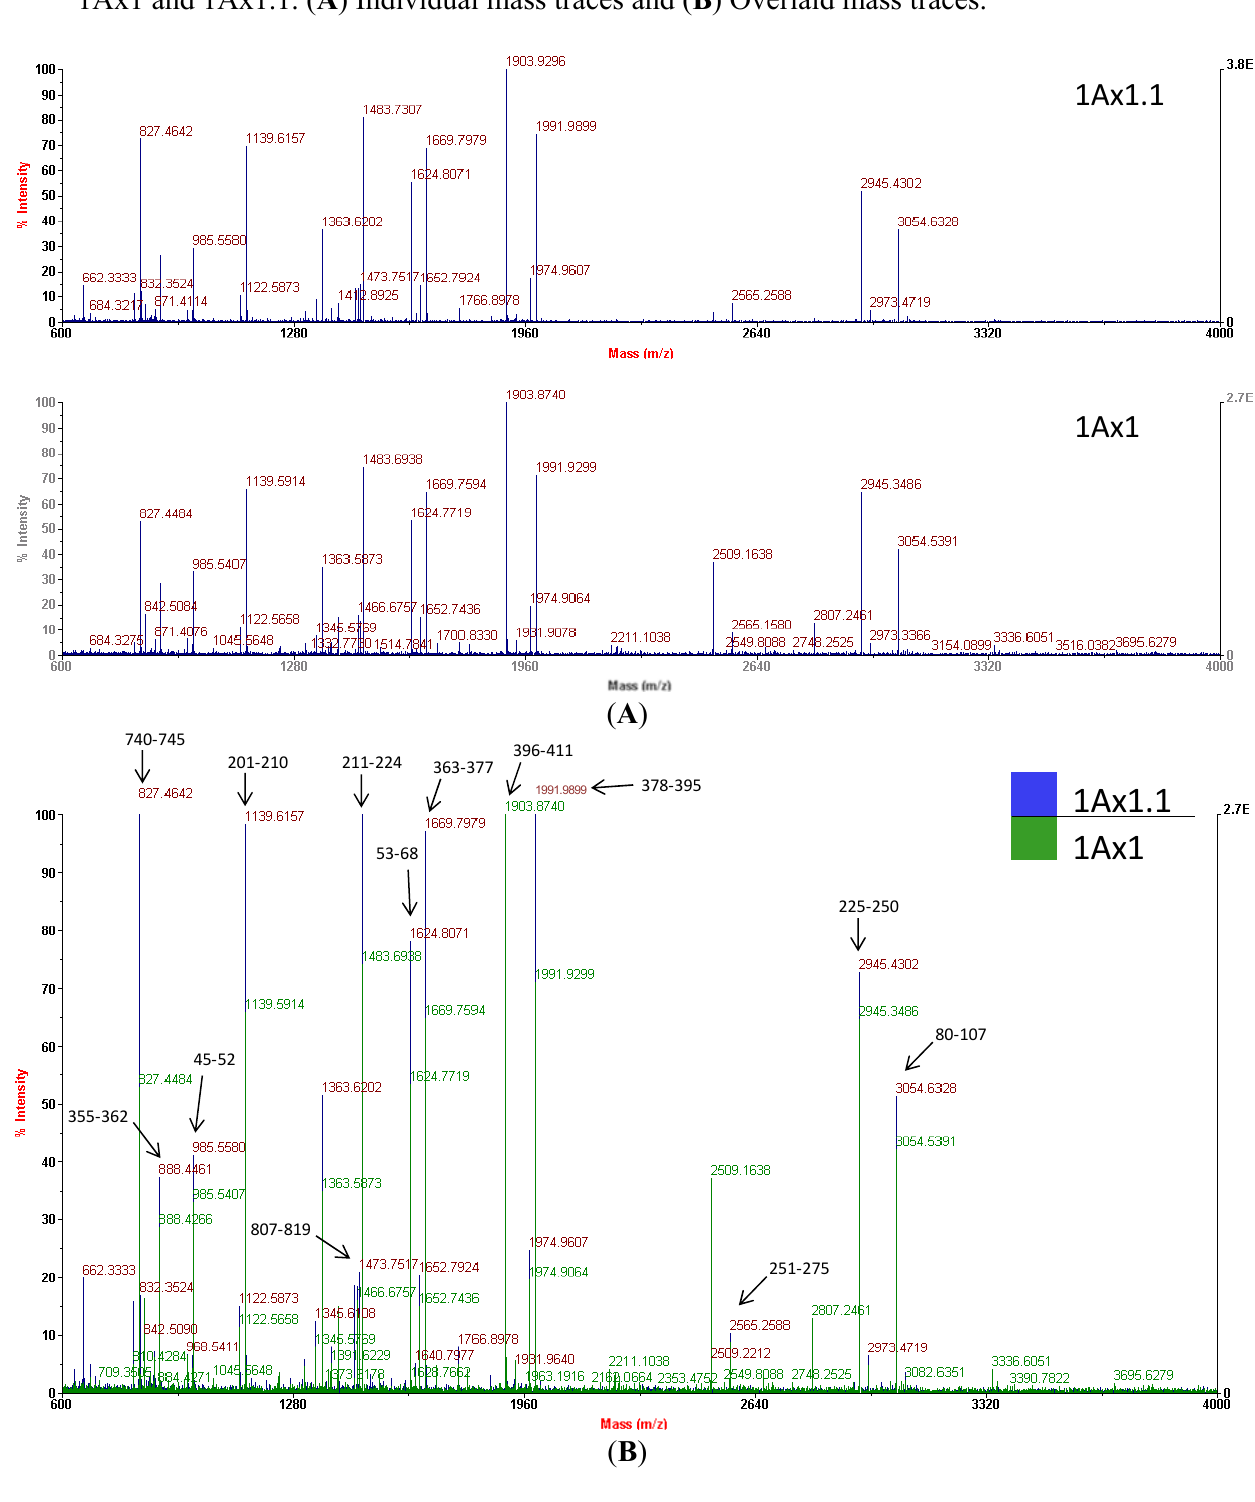
Figure 4. MALDI-TOF mass spectra of the two high molecular weight glutenin